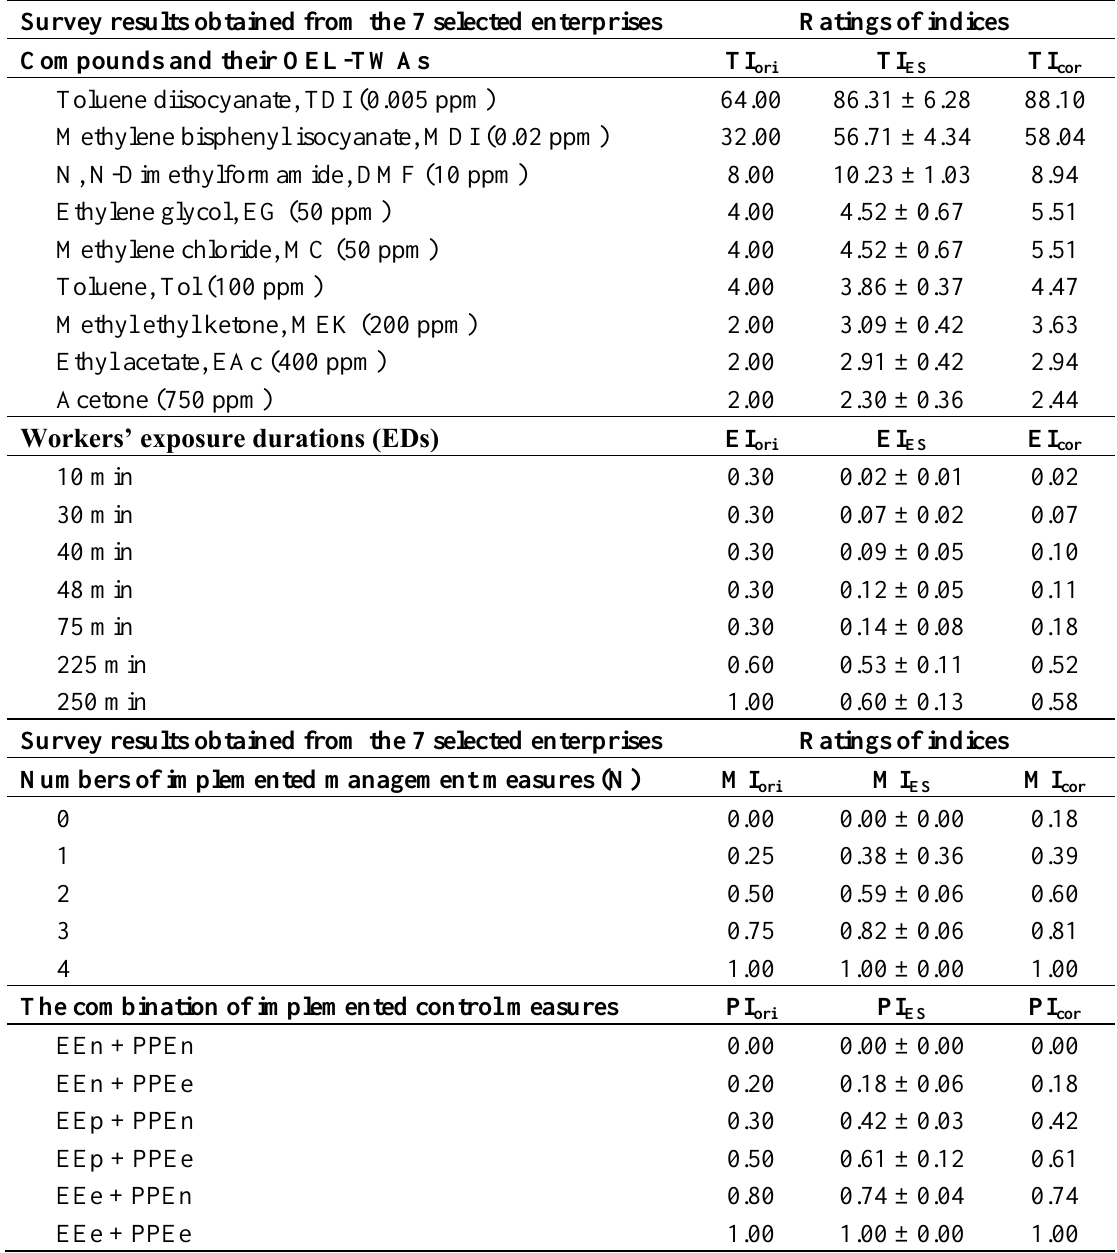
, EI , and PI ), expert system (TI ori ori ori , EI , and PI cor cor cor